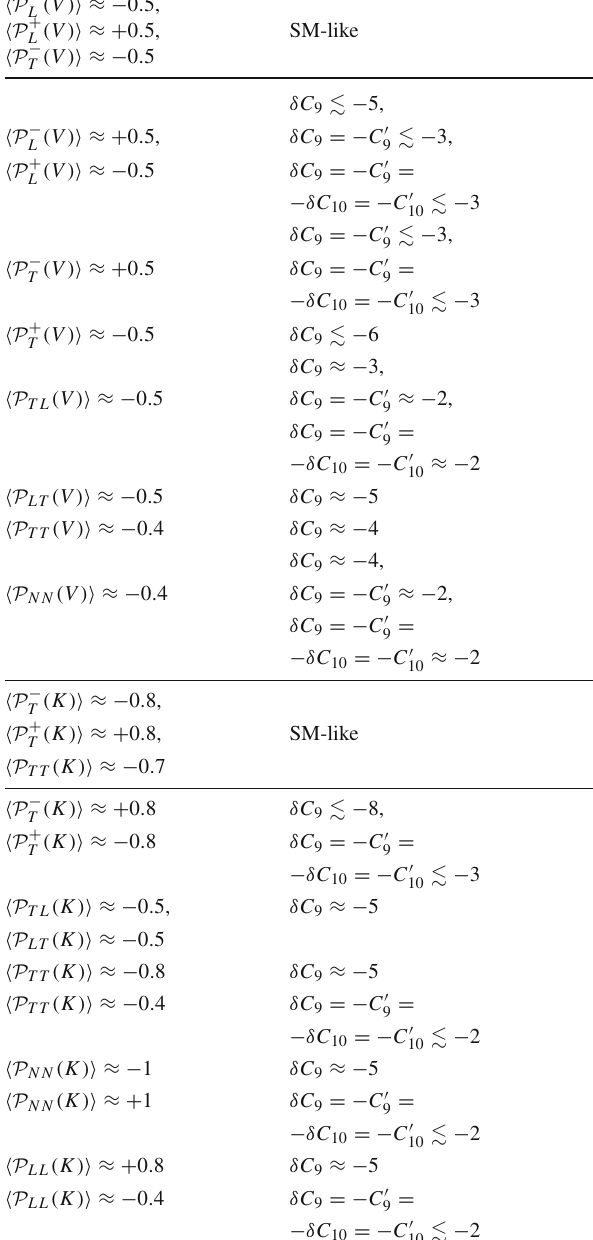
Table 5 Non-exhaustive table making the correspondence between the observation of an asymmetry at or beyond the level ± 0 . 4, and the phys- ical scenarios among NP1 , NP2 , NP3 this observation implies. Below V = K ∗ ,φ . Of course, the non-observation of (cid:11) P ± (cid:11) P ± ( K ) (cid:12) , (cid:11) P ( K ) (cid:12) at a sizable level also implies the existence of TT T physics beyond the SM, which is not discussed in this